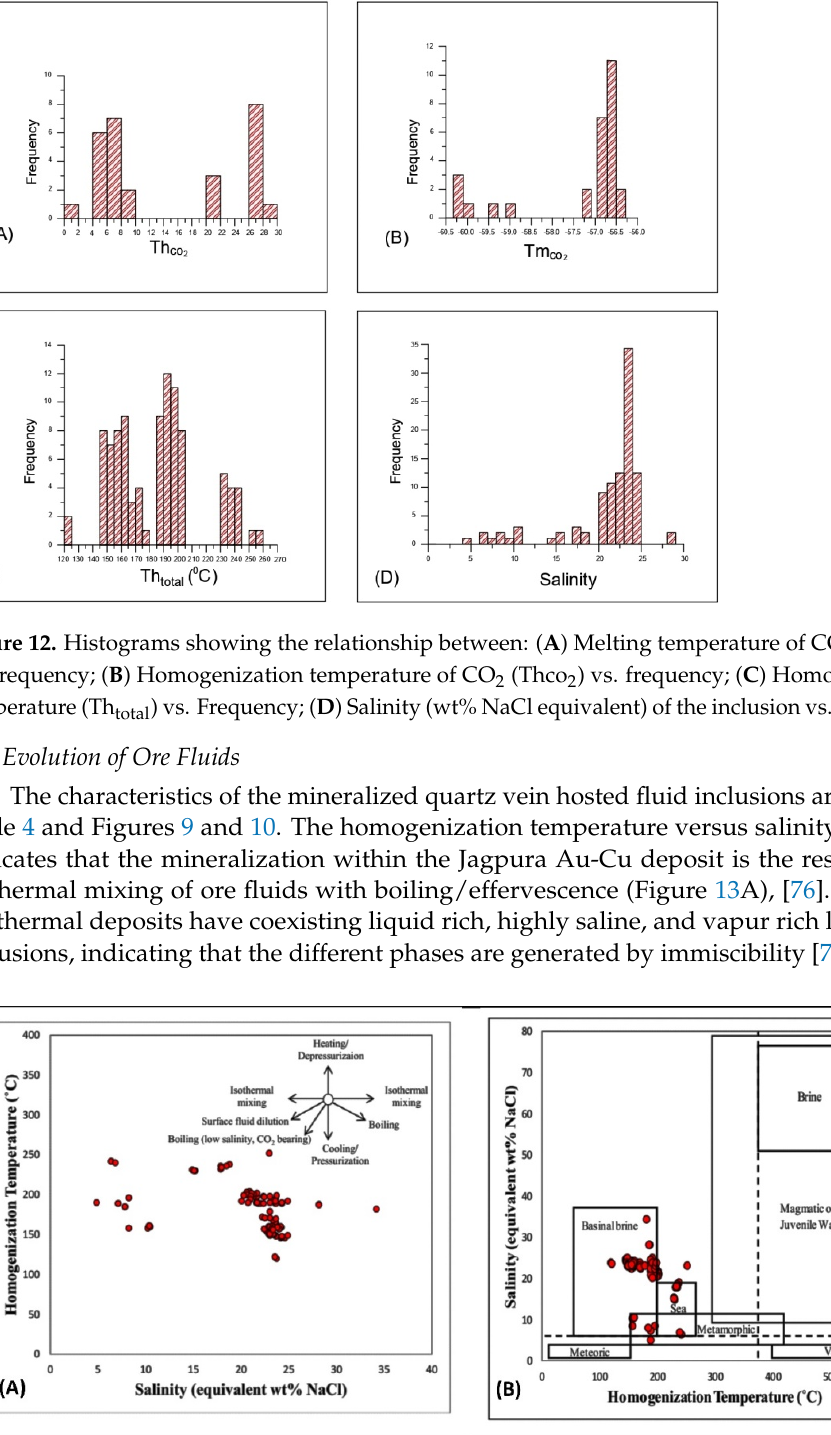
Figure 13. Homogenization temperature vs. salinity diagram of fluid inclusions from study area: ( A ) showing typical trends in homogenization temperature-salinity space due to various fluid evo- lution processes, from reference [78]; ( B ) Salinity vs. Homogenization temperature diagram from reference [79] indicates mixing of basinal brine, sea water and metamorphic fluids in ore